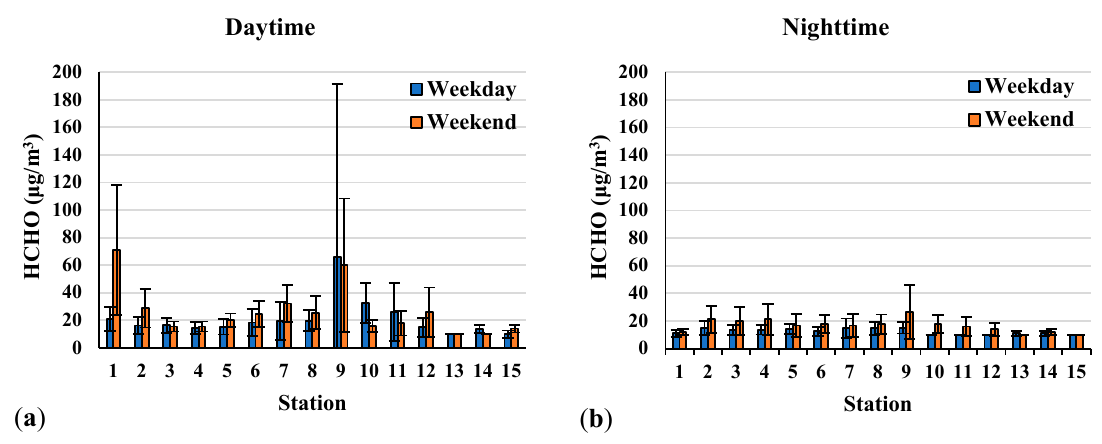
Figure 5. Average HCHO concentrations inside the train carriage for daytime and nighttime for all 15 stations. ( a ) HCHO concentrations for daytime, and ( b ) HCHO concentrations for nighttime.